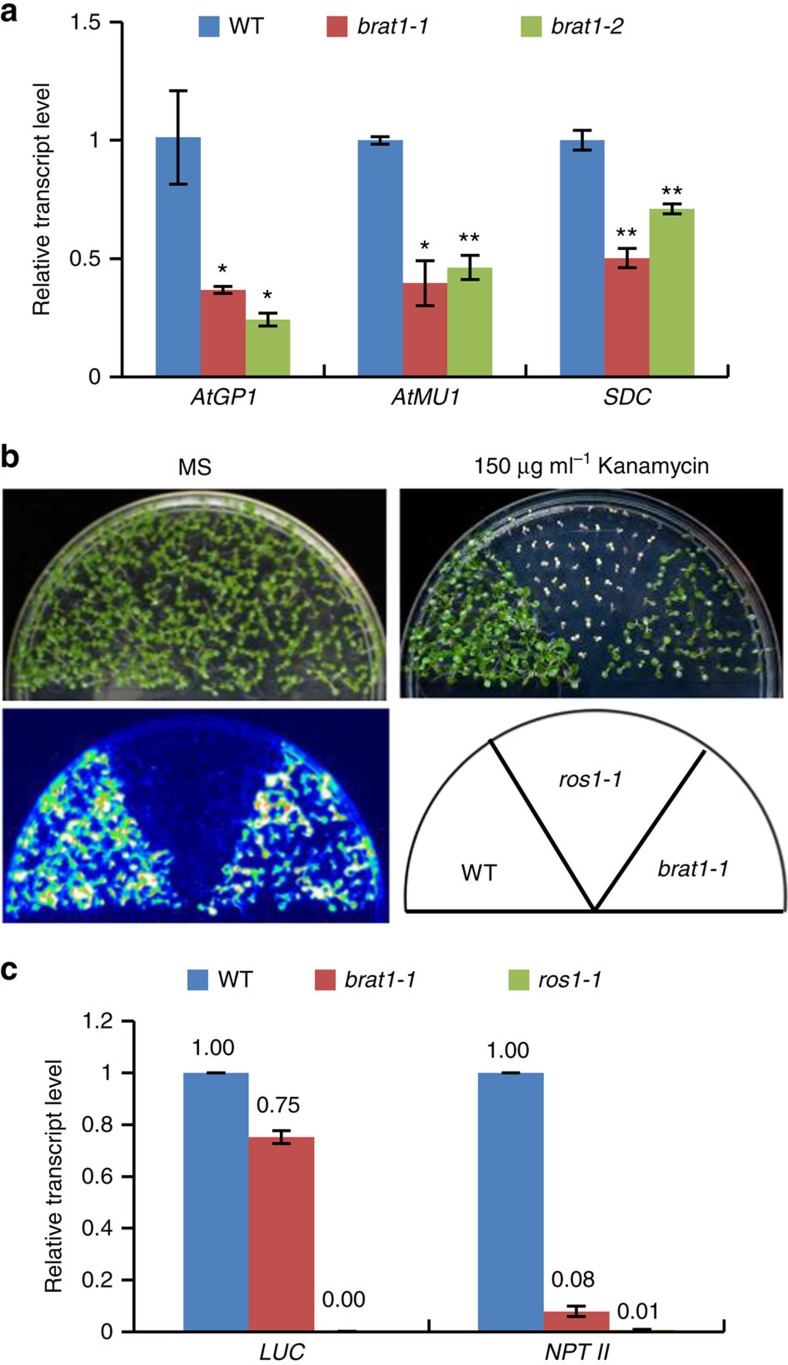
BRAT1 contributes to transcriptional anti-silencing.(a) The RNA transcripts of AtGP1, AtMU1 and SDC were detected by quantitative RT–PCR in the WT (wild-type) col-0 and the two individual brat1 mutant alleles brat1-1 and brat1-2. The actin gene ACT7 was amplified as an internal control. Asterisks indicate statistical significance as determined by Student's t-test (**P<0.01; *P<0.05). (b) The effect of brat1 on the expression of RD29A-LUC and 35S-NPTII transgenes was determined by luminescence imaging and kanamycin sensitivity, respectively. The RD29A-LUC and 35S-NPTII reporter genes were introduced into the brat1-1 mutant by crossing. (c) The RNA transcripts of RD29A-LUC and 35S-NPTII were detected by quantitative RT–PCR. Error bars represent s.d. of three biological replicates.